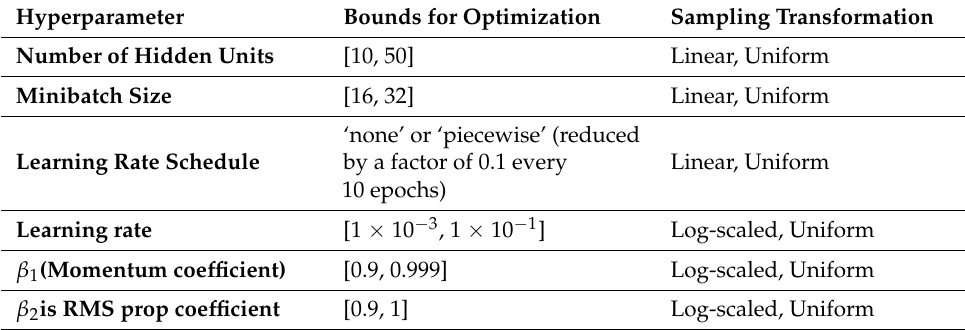
Table 3. BOpt search space for each of the hyperparameters that were optimized.